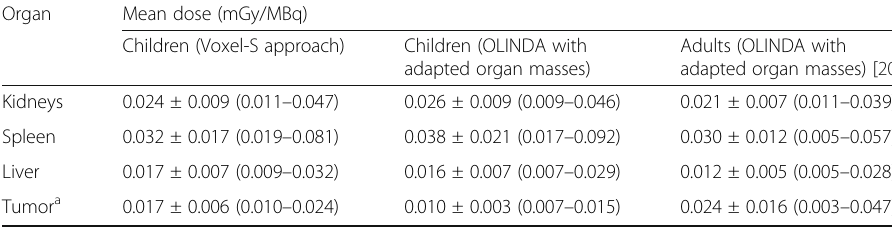
Table 4 Comparison of absorbed doses in organs and tumors in children and adults Organ Mean dose (mGy/MBq) Children (Voxel-S approach) Children (OLINDA with Adults (OLINDA with adapted organ masses) adapted organ masses) [20]